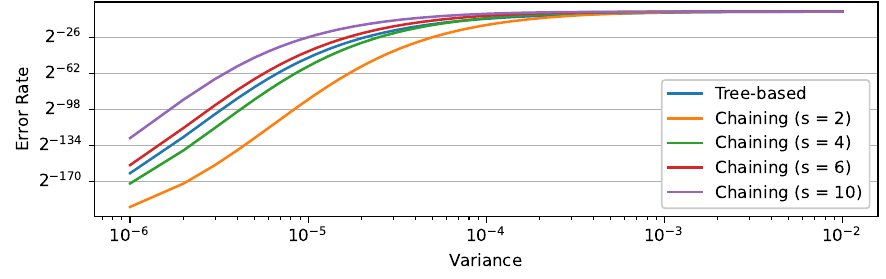
Figure 3: Comparison between the error rates of the tree-based and chaining